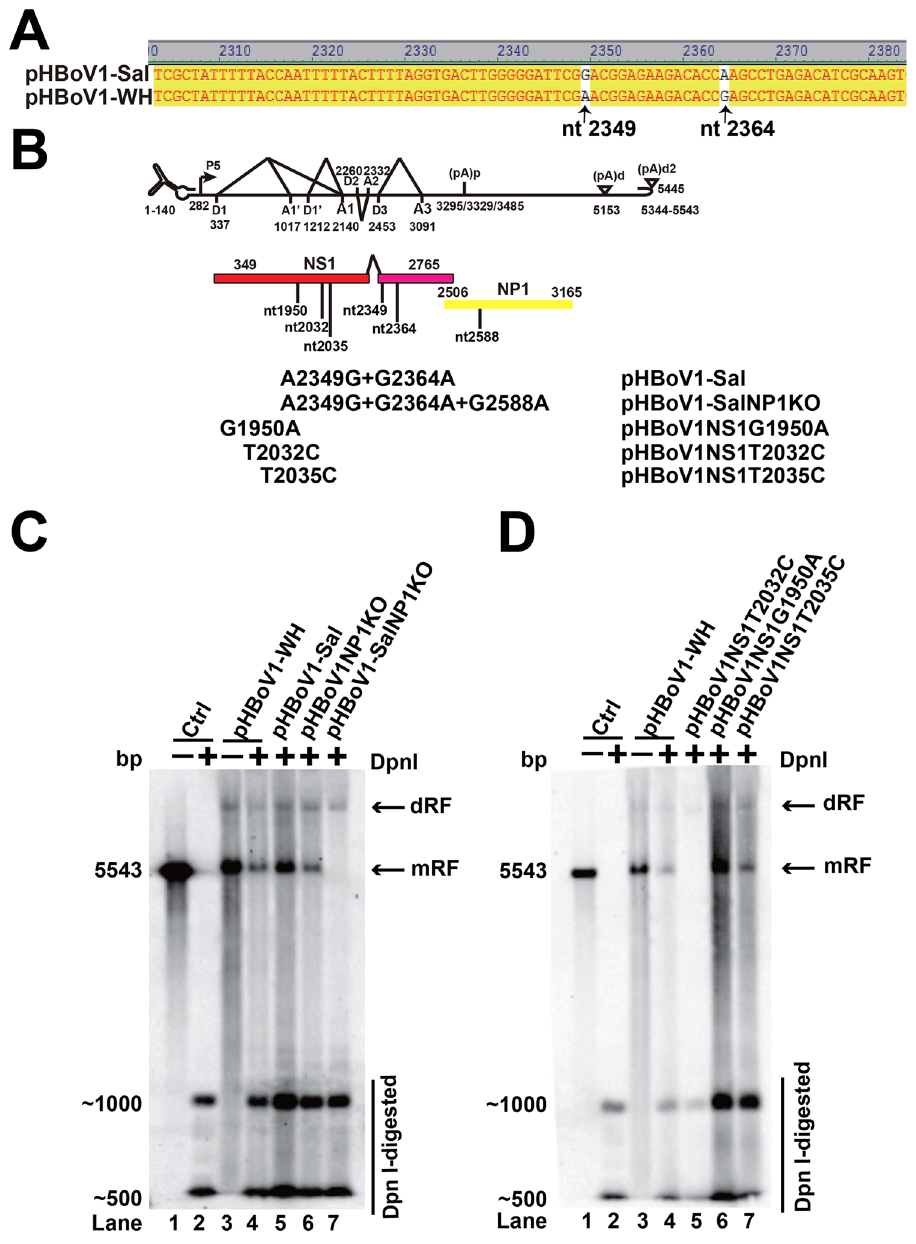
Figure 2. Mutations in the C-terminus of NS1 ORF influenced HBoV1 viral DNA replication and NP1 function. ( A ) Sequence alignment. The NS1 sequences of Wuhan isolate and Salvador strain were aligned. The mutations at nt 2349 and nt 2364 were indicated. ( B ) Diagram of mutated plasmids of NP1 and NS1. Mutations at nt 2349 and nt2364 in the Wuhan isolate were mutated to the sequence of Salvador strain. Random mutations in NS1 at nt 1950, 2035 and 2032 were indicated. ( C , D ) Southern blot analysis. Plasmids in panel B were transfected into HEK293T cells and the viral DNA was harvested 48 h after transfection. Dpn I digestion was performed and followed by Southern blot analysis. The signal was detected by ChemiDoc TM MP imaging